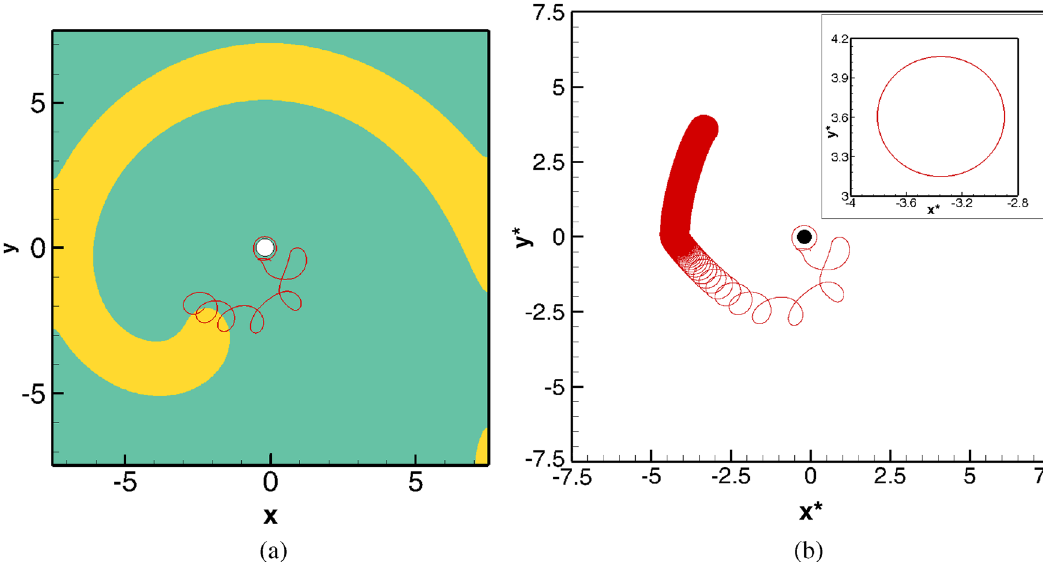
Figure 4. Dynamics of spiral wave in the presence of a circular obstacle for a = 1.40 : ( a ) the tip trajectory during 100 ≤ t ≤ 110.00 , along with spiral wave pattern at t = 110 , ( b ) tip trajectory for 100.00 ≤ t ≤ 1500.00 along with the one during the final time range 1450 ≤ t ≤ 1500 at the inset.